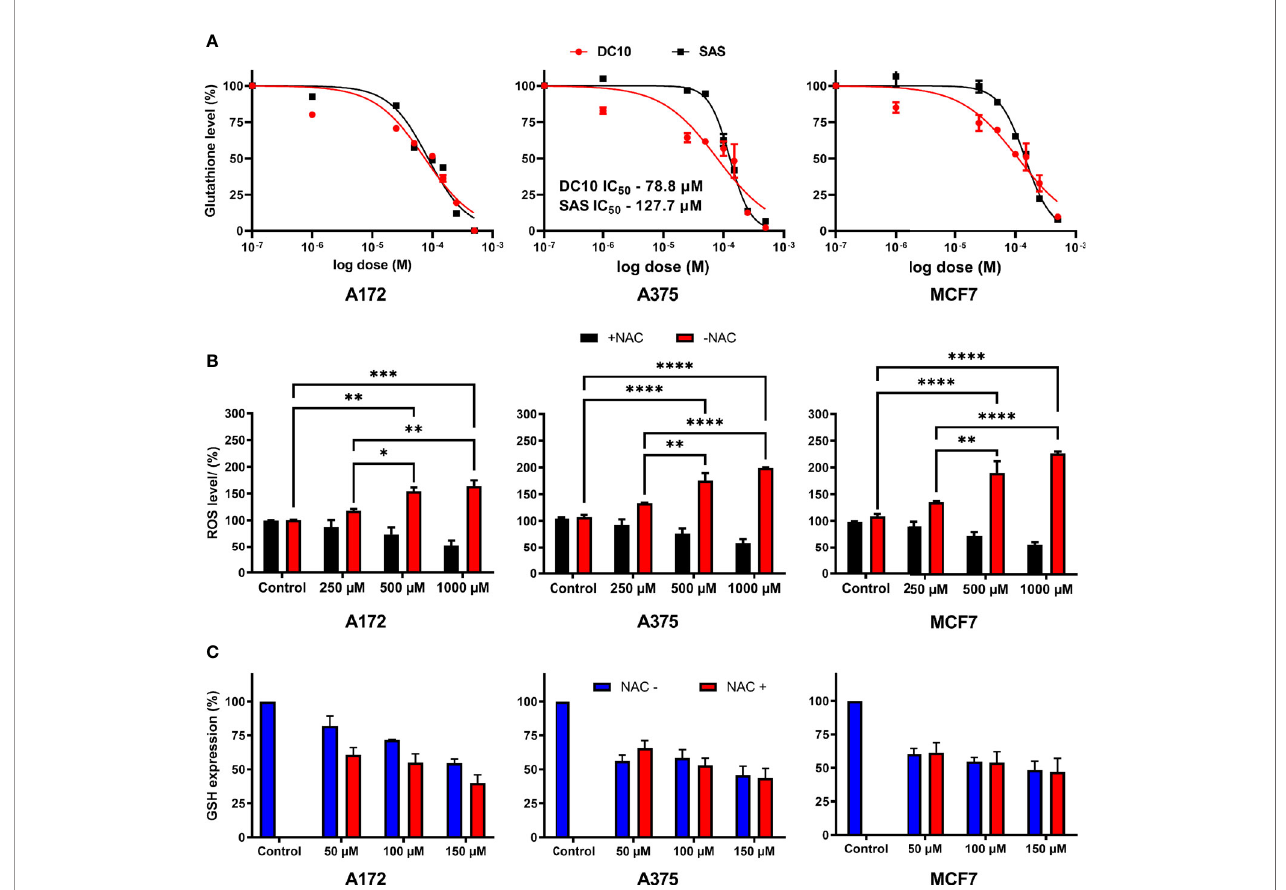
FIGURE 2 | Dose-dependent effect of DC10 on GSH and ROS levels in cancer cell lines. (A) GSH levels in the A172, A375 and MCF7 cell lines in controls and after DC10 treatment with doses as indicated. (B) ROS levels after DC10 treatment with doses as indicated. *P < 0.05, **P < 0.01, ***P < 0.001, ****P < 0.0001. (C) GSH expression in DC10 treated cells in the presence or absence of NAC as